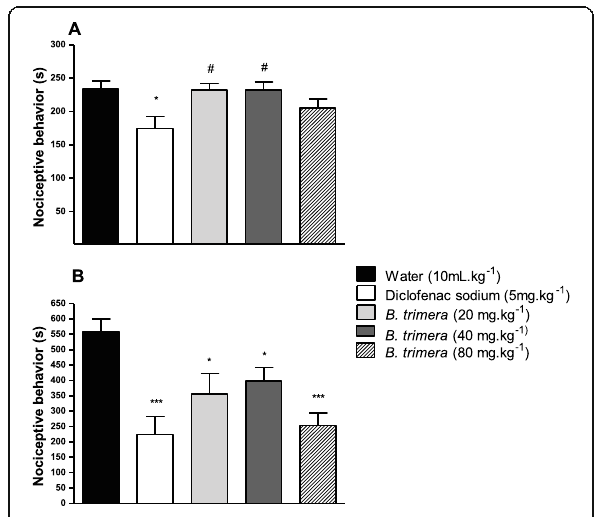
Fig. 2 Antinociceptive effects produced by the B. trimera aqueous extract after the formalin model. ( A ) The neurogenic phase and ( B ) the inflammatory phase - 1h before the administration (i.pl.) into the right paw. Each bar represents the mean±standard error of 7 – 14 mice, depending on the group. * p <0.05 or *** p <0.001 represent the level of significance when compared to the water-treated animals; and # p <0.05